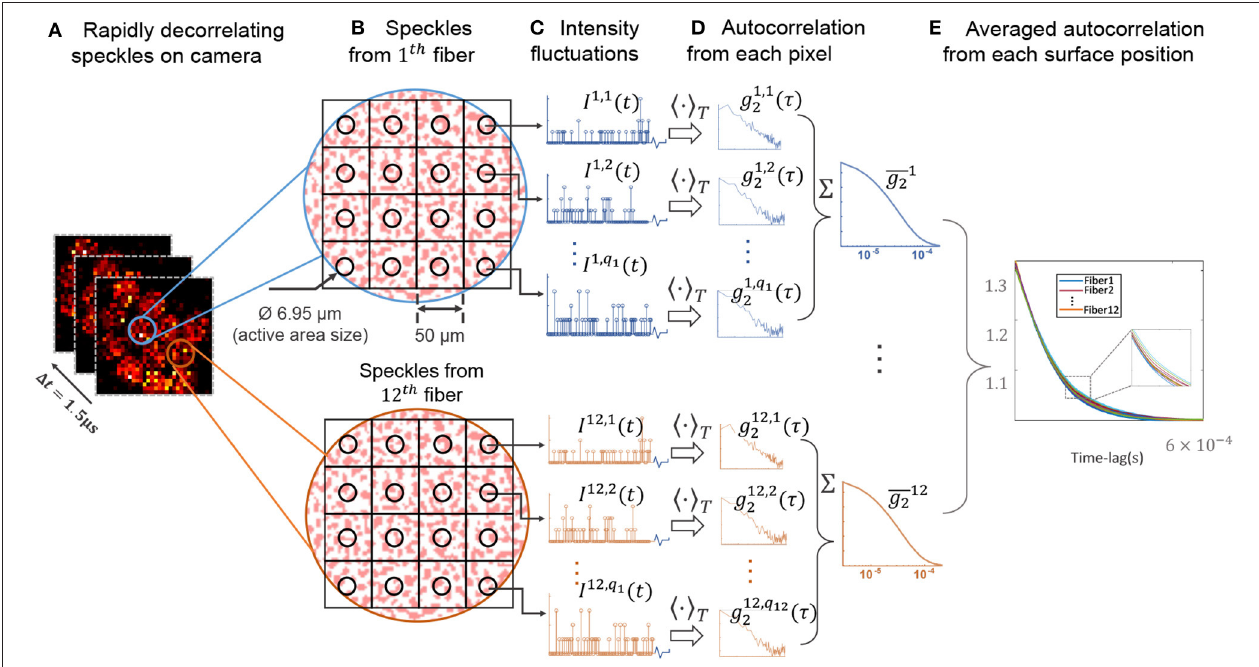
FIGURE 3 | Method for computing the autocorrelation curves detailed in Section 2.2. (A) Shows a few representative frames captured with the SPAD array. (B–E) Shows the data processing method, where the autocorrelation from each SPAD pixel were computed, and averaged across each fiber position to generate a set of curves for each decorrelating event.